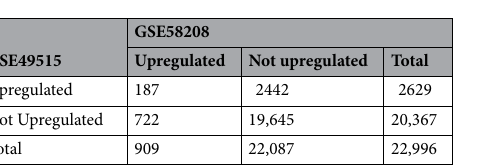
Figure 1. Summary of the experiment. ( a ) Venn diagram based on the overlapping number of upregulated genes between two microarray data extracted from Gene Expression Omnibus (GEO) data repository. ( b ) A schematic design flow of the experiment.